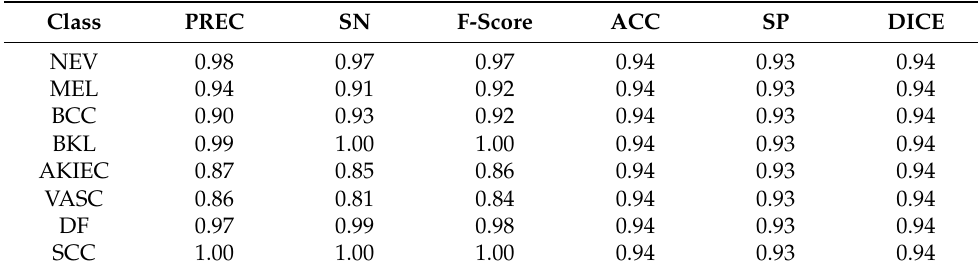
Table 5. The optimized CNN model evaluated on the ISIC2019